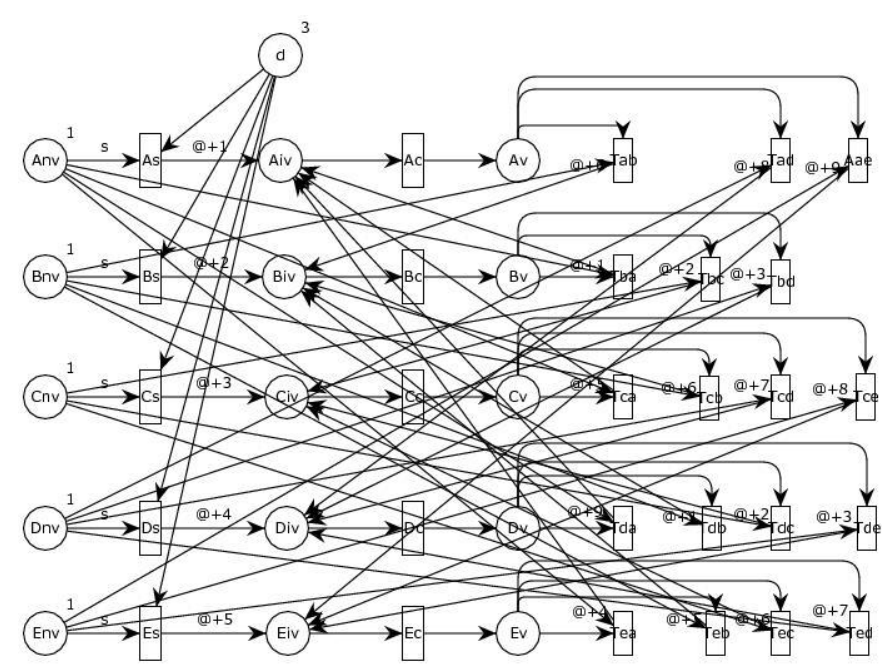
Figure 14. mTSP involving five partially connected cities, a depo and three salesmen with asymmetric cost matrix.